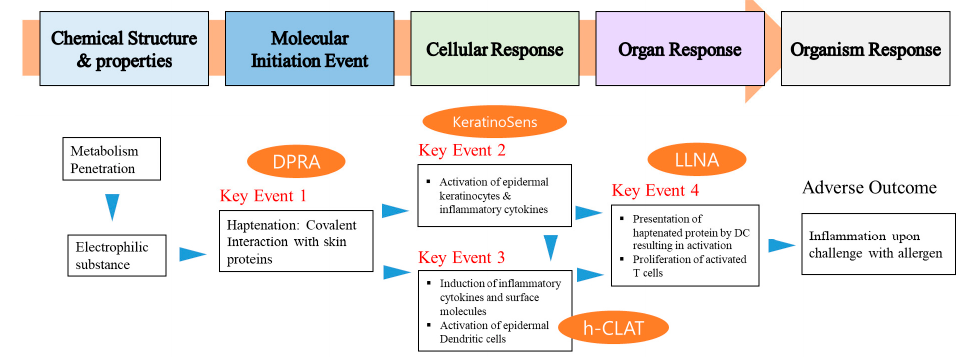
Figure 6. Overview of skin sensitization adverse outcome pathway